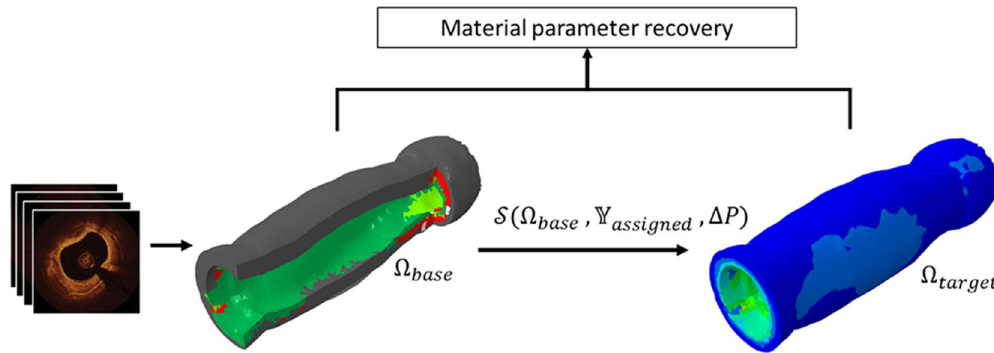
Figure 3. Verification of material recovery using target geometries generated through computational simulations. The imaging data were first converted into a patient-specific FE mesh ( (cid:31) base ) with material heterogeneity. Material properties (comprising vectors Y assigned ) were then assigned to each tissue class. Pressure (ΔP) was applied to the lumen and the displacements calculated via FE simulation ( S ). The resultant